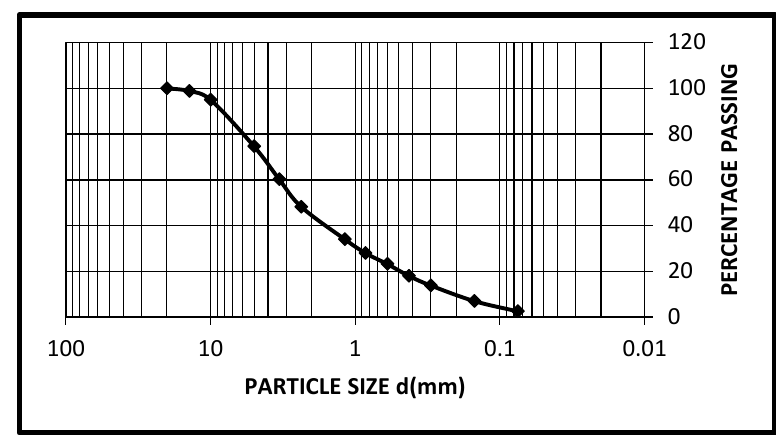
Fig. 1. Grain Size Distribution of Ikpayongo Laterite.